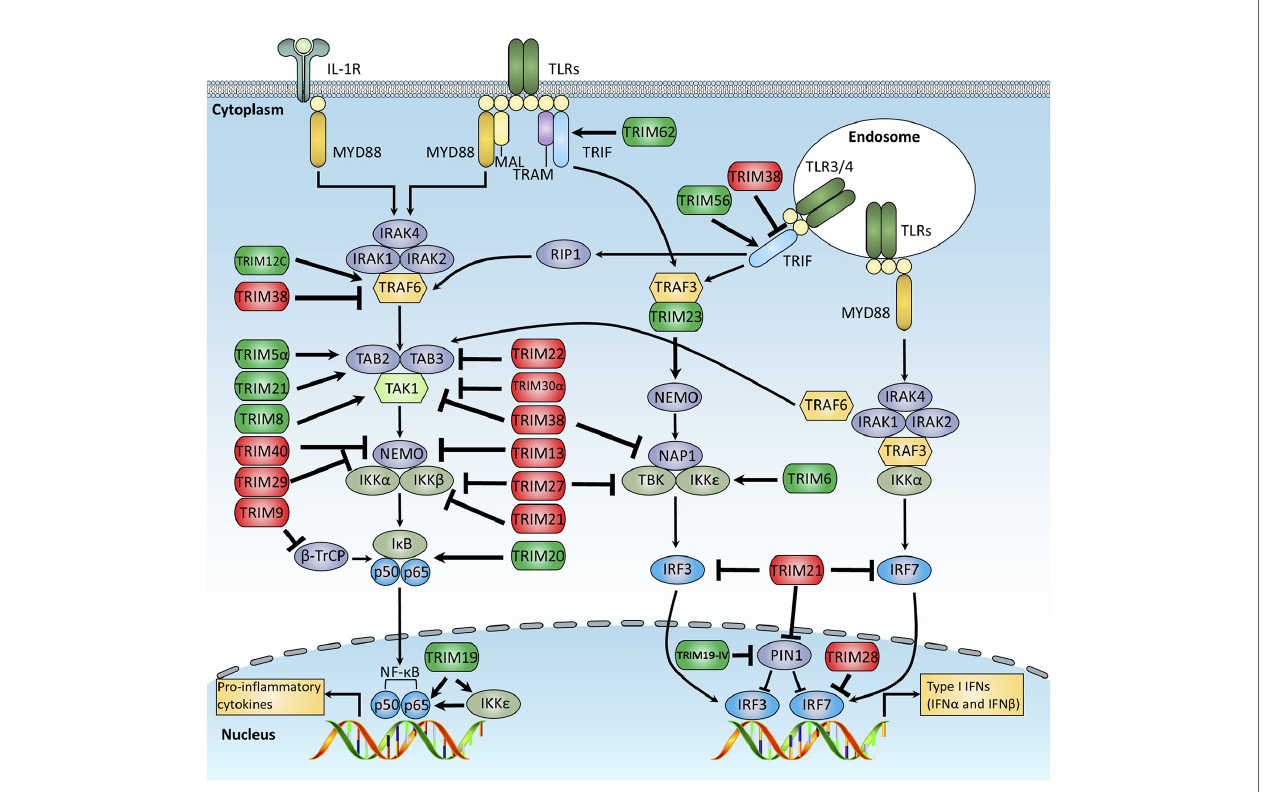
FIGURE 2 | Schematic diagram of TRIM-mediated regulation of the TLR signaling pathway. The TLR signaling is divided into two distinct pathways: the MyD88- and TRIF-dependent pathways. In the MyD88-dependent pathway, activated MyD88 recruits and further activates the IRAK1 kinase complex, which then recruits TRAF6, an E3 ligase that undergoes auto-ubiquitination and mediates the recruitment and auto-phosphorylation of TAK1 complex. Activated TAK1 promotes I k B a phosphorylation, which leads to the degradation of I k B a , and releases NF- k B p50/p65 subunits into nuclear, promote the production of a subset of proin fl ammatory cytokines. In the TRIF-dependent pathway, activated TRIF recruits TRAF3, an E3 ligase that mediates the activation of TBK1, leading to the phosphorylation and dimerization of IRF3 to promote the production of IFN-I. This fi gure overviews the known TRIM proteins that regulate the TLR signaling pathway, in which the TRIMs promoting TLR signaling are indicated in green, whereas those suppressing TLR signaling are indicated in